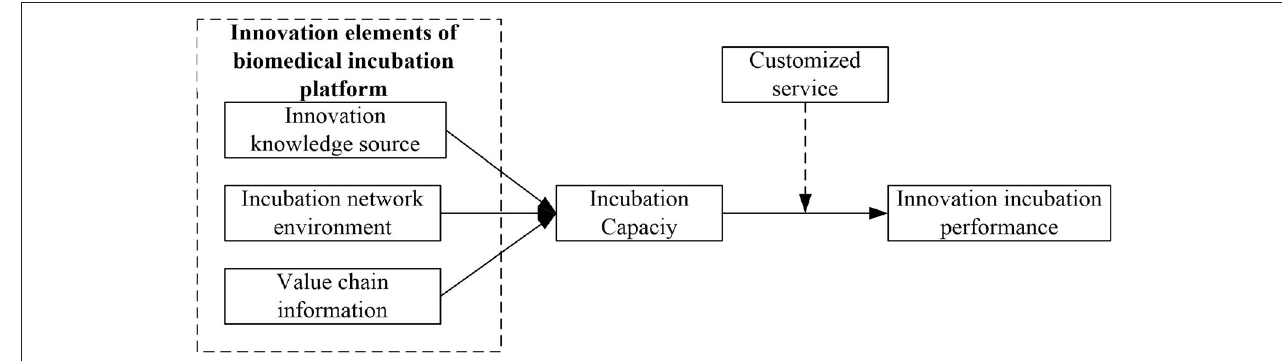
FIGURE 1 | Conceptual